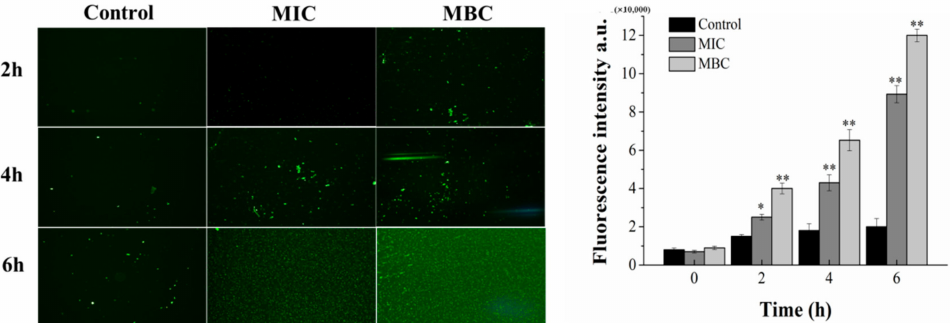
Figure 5. Changes in intracellular ROS content. (Each bar represents the mean ± SD of three independent experiments, * p < 0.05 versus the control group, ** p < 0.01 versus the control group).